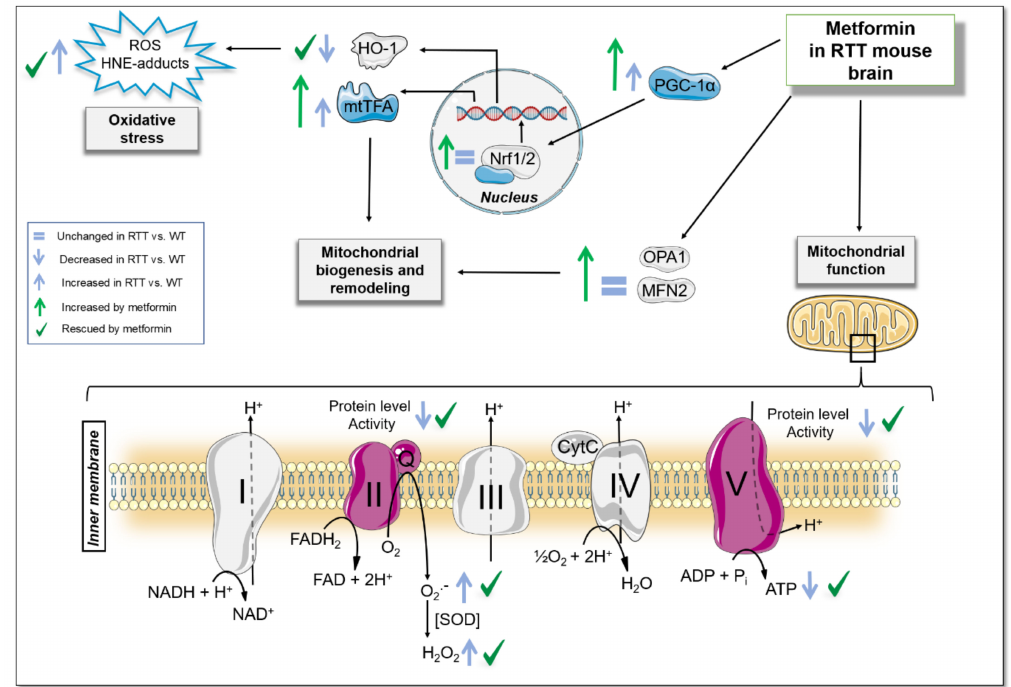
Figure 8. Summary Diagram. A 10-day long treatment with metformin normalizes the reduced mitochondrial ATP production and ATP levels in whole brain of a validated RTT mouse model at an advanced stage of the disease. This is achieved through the restoration of the defective activity of mitochondrial respiratory chain complex II and V and of their reduced protein content. These beneficial e ff ects are accompanied by a strong activation of signaling pathways related to both mitochondrial biogenesis and remodeling (PGC-1 α / mtTFA, OPA1 and MFN2) selectively in RTT mouse brain. Metformin also ameliorates prooxidant status and brain oxidative damage in RTT brain, through the stimulation of Nrf2 signaling and the consequent transcription of antioxidant genes such as HO-1. WT: wild-type mice; RTT: MeCP2-308 heterozygous female mice;